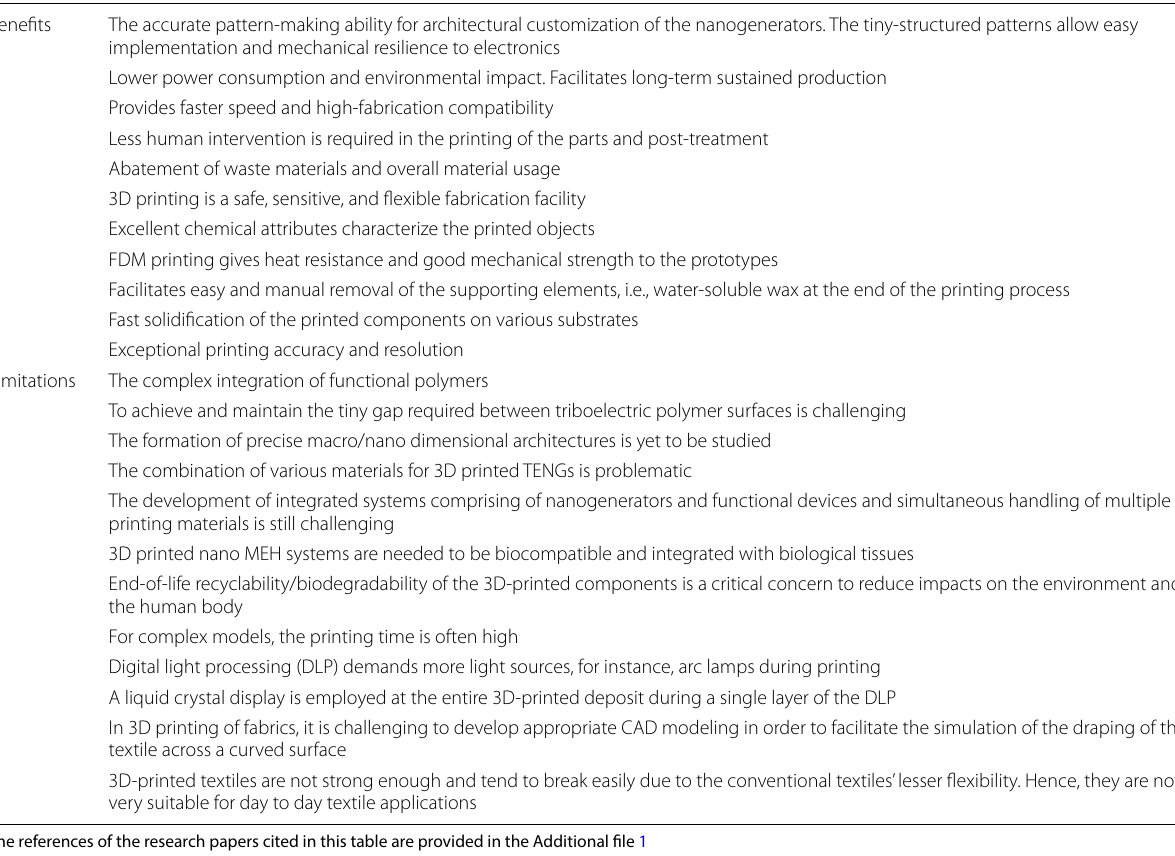
Table 9 Benefits and challenges related to 3D-printing of the nano MEH systems